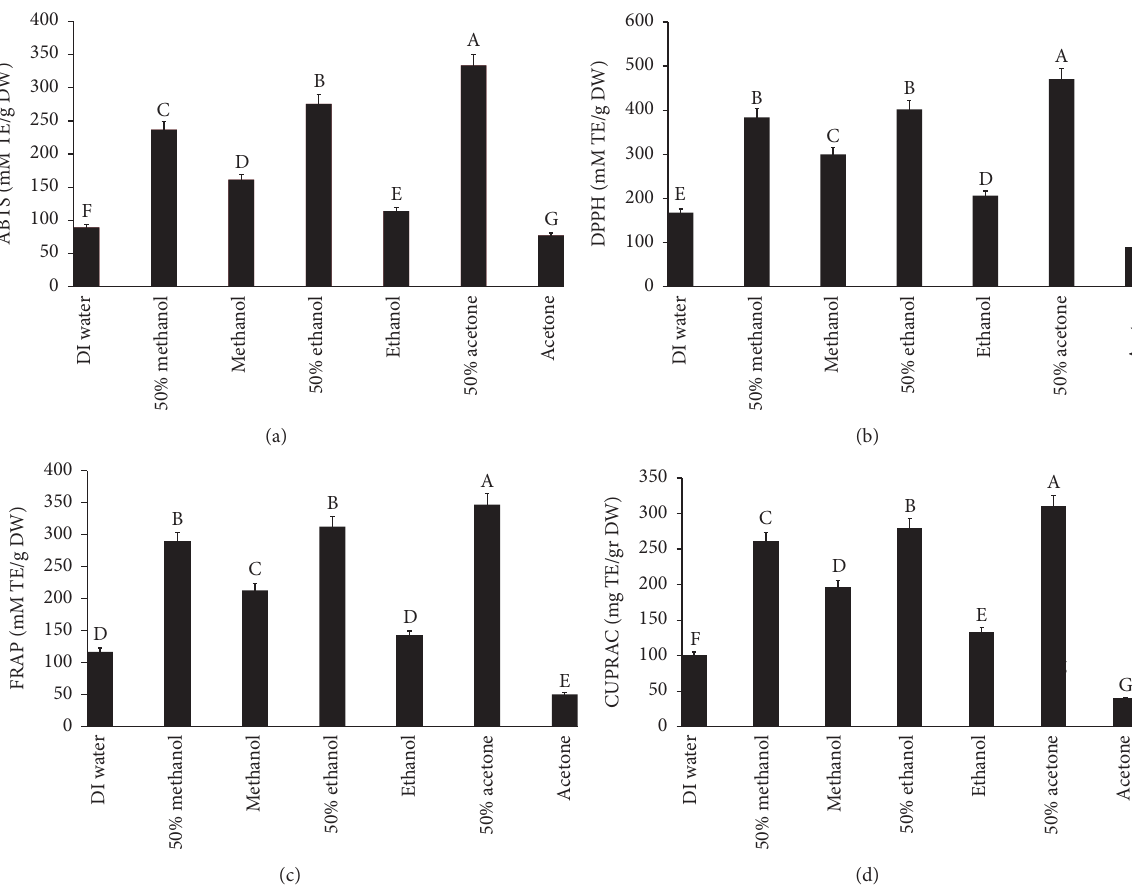
Figure 3: Effect of solvents on antioxidant properties from the root of S. chinensis using various antioxidant assays, including ABTS, DPPH, FRAP, and CUPRAC. The values are the mean of three replications for each solvent ± standard deviation. Columns not sharing the same superscript letter are significantly different 𝑝 < 0.05 (DI water: deionized water).